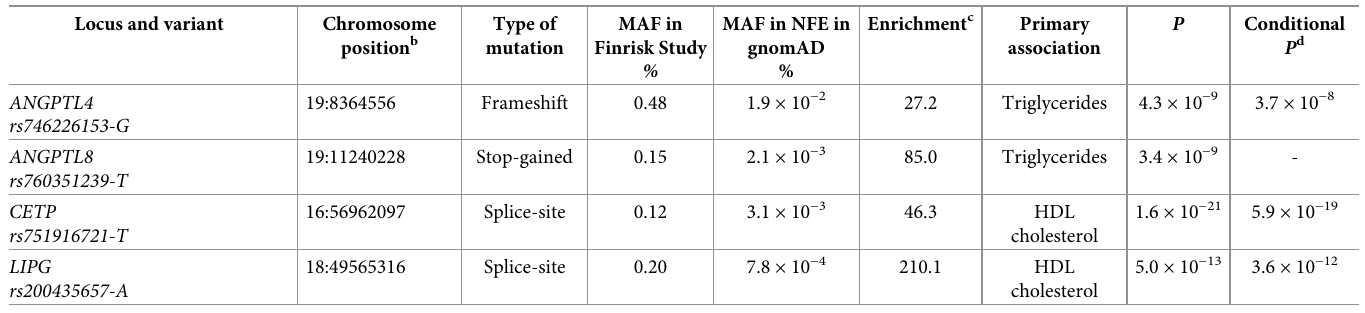
Locus and variant